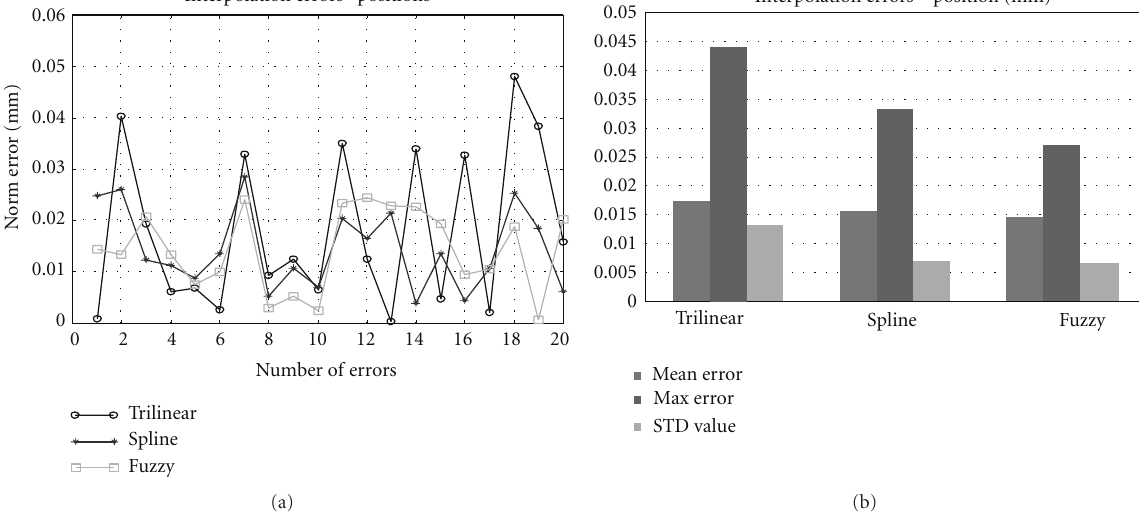
Figure 6: Simulated interpolation results—position errors.